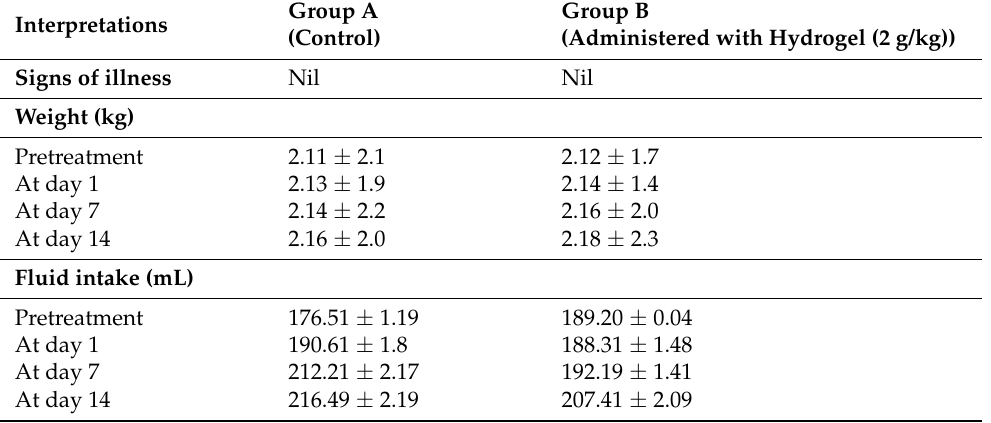
Table 3. Medical interpretation of acute oral